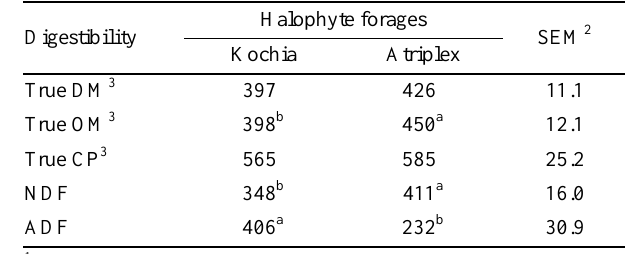
Table 2. Nutrient digestibility of Kochia scoparia and